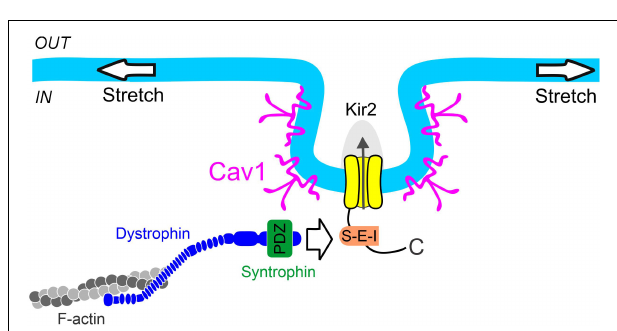
FIGURE 5 | Proposed mechanism of smooth muscle Kir2 channel mechanosensitivity. Syntrophin binds to the C-terminal PDZ binding motif (S-E-I) of Kir2 channels residing in caveolae-like structures formed through the expression of caveolin-1 (Cav1). Dystrophin interacts with both syntrophin and filamentous actin (F-actin), providing a physical link between the Kir2 channel and cytoskeleton for force transmission. These structural components constitute a multiprotein signaling complex which confers pressure sensitivity to smooth muscle Kir2